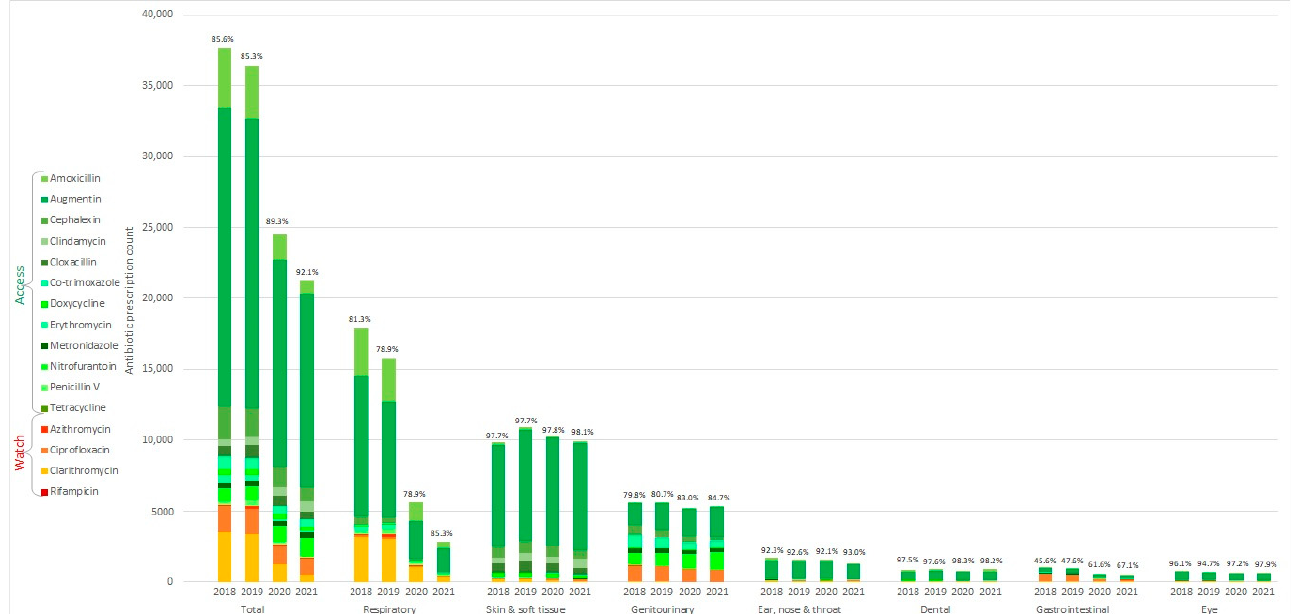
Table 3. Topical ENT antibiotic prescriptions, 2018–2021.